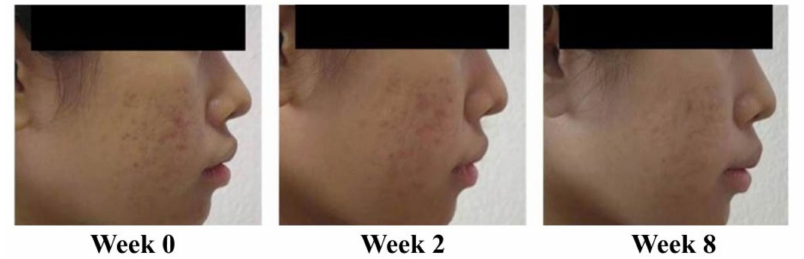
Figure 3. Case study: a 23-year-old female with mild-severity acne vulgaris at the baseline (IGA (Investigator Global Assessment) scale = 2, some non-inflammatory lesions with no more than a few inflammatory lesions). By week 8, following the treatment with 1% liposomal encapsulated rhodomyrtone serum twice daily, a change in severity to almost acne vulgaris-free occurred (IGA scale = 1, rare non-inflammatory with no more than one small inflammatory